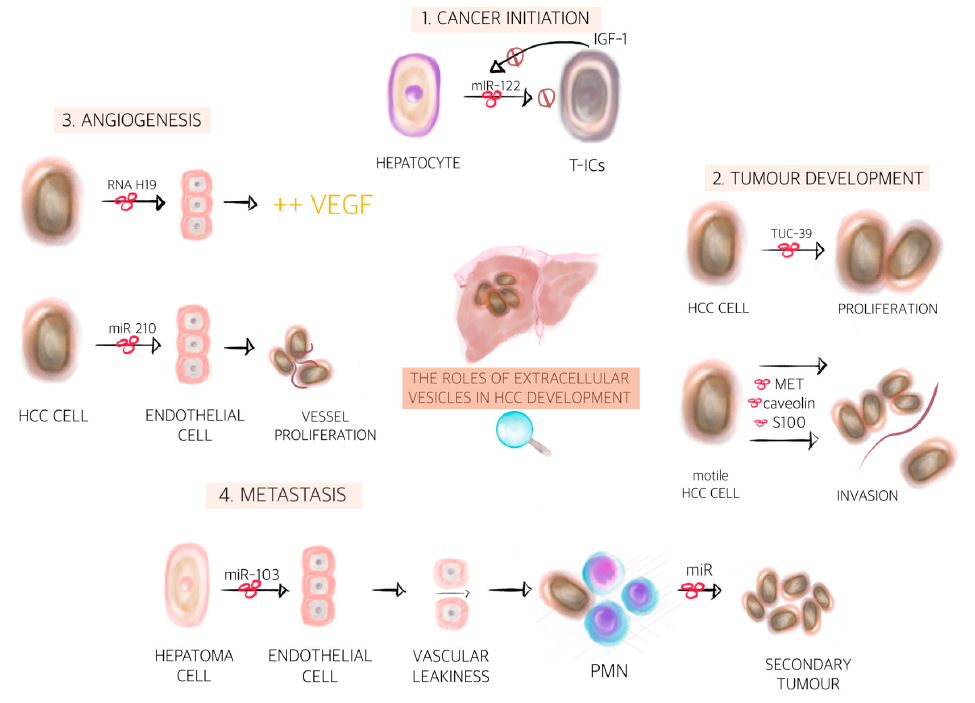
Figure 2. The roles of extracellular vesicles in hepatocellular carcinoma development. Extracellular vesicles are involved in many stages of carcinogenesis and represent important key-players among normal cells, tumour cells and the tumour microenvironment. We illustrate the most important steps of primary liver cancer development mediated by extracellular vesicles, as follows: (1) cancer initiation (transformation or blockage of the hepatocytes into tumour cells); (2) tumour development (proliferation + invasion); (3) angiogenesis (synthesis of vascular endothelial growth factor and vessel proliferation); and (4) metastasis (inducing vascular leakiness, thus facilitating invasion and formation of the pre-metastatic niche and finally leading to secondary tumours) [134,136,138,139,148,149]. Abbreviations: IGF-1, insulin growth factor-1; T-ICs, tumour initiating cells; miR, microRNA;